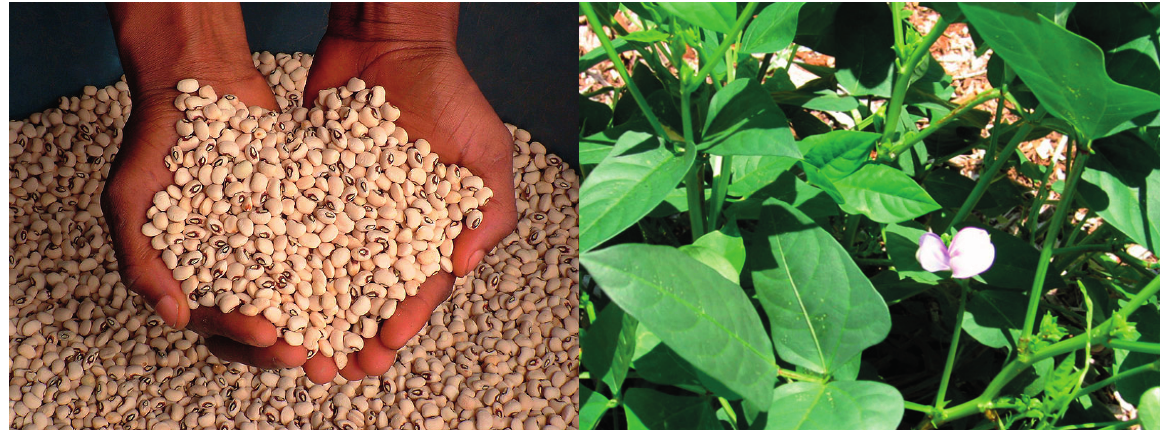
Figure 6. Cowpea seed ( Left : black-eyed cowpea) and a cowpea plant ( Right ) at the flowering stage of growth. Source